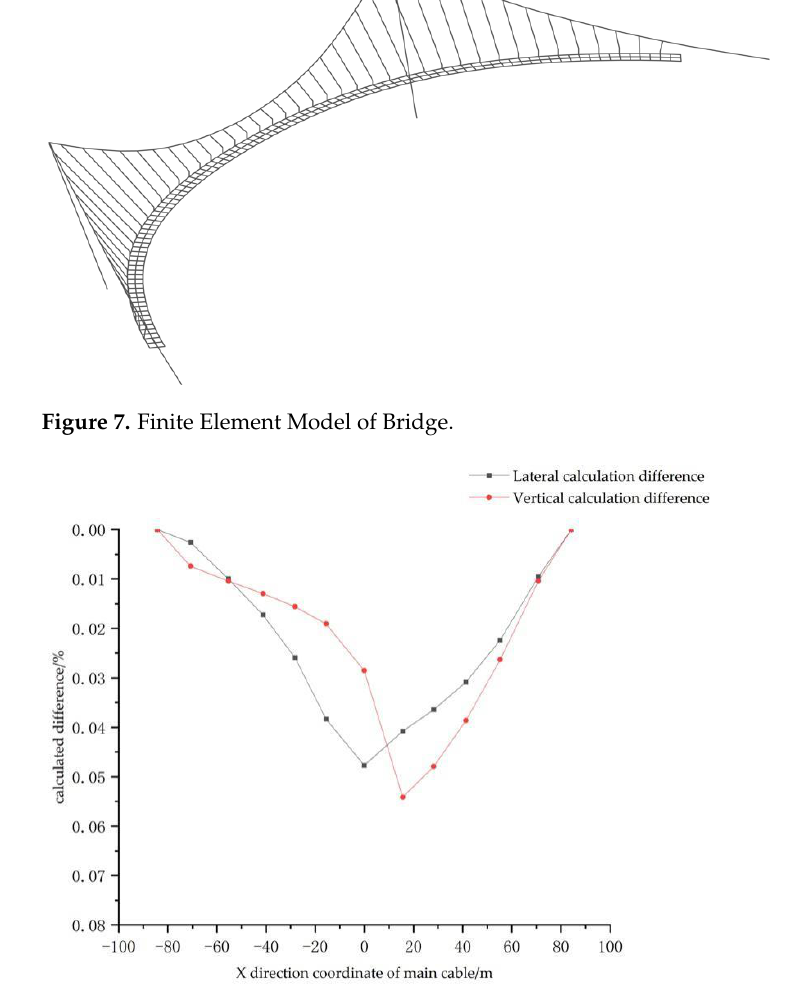
Figure 8. Calculation error between finite element method and hybrid quantum genetic algorithm.